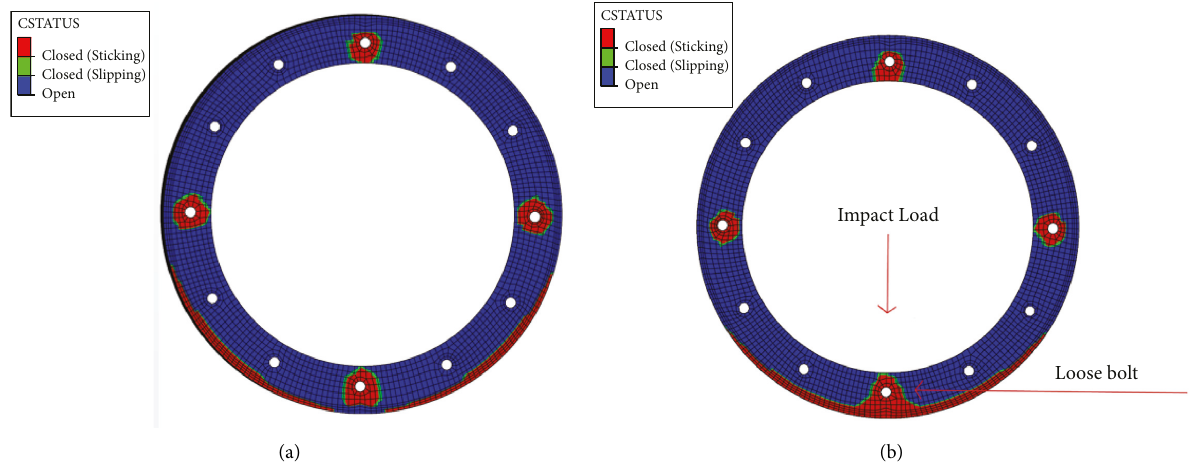
Figure 15: Connection surface contact state (4 bolts in the structure under 1500N impact load on the top). (a) No loosening with 5000N bolt preload. (b) Loosening to 300N bolt preload.